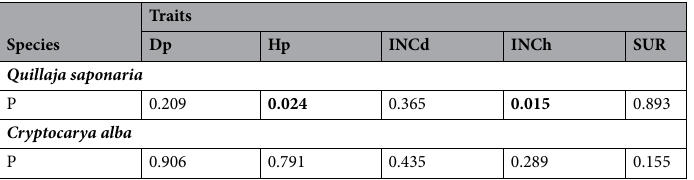
Table 2. Analysis of variance for growth and survival traits of Q . saponaria and C . alba seedlings 1 year after outplanting. P provenance, Dp root collar diameter (mm), Hp height (cm), INCd increment in D (mm), INCh increment in H (cm), SUR survival (%). Statistically significant values ( P < 0.05) are in